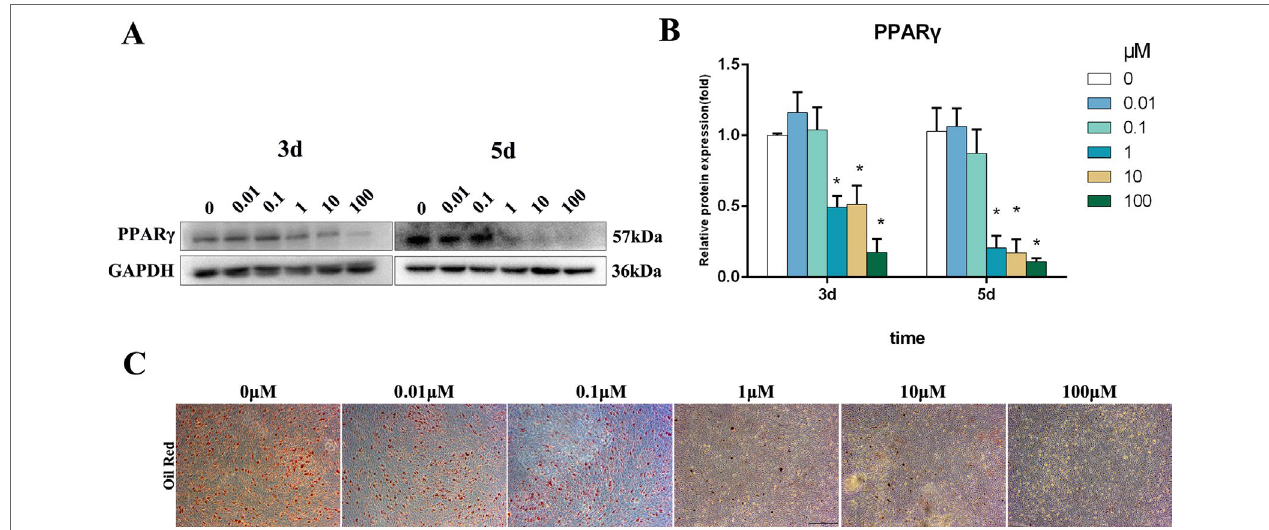
FIGURE 3 | Effects of Bergenin on adipogenesis of bone marrow mesenchymal stem cells (BMSCs). (A and B) The expression of PPAR γ protein was determined by Western blot analysis after adipogenic differentiation at days 3 and 5. Protein expression levels were normalized to glyceraldehyde-3-phosphate dehydrogenase. * P < 0.05 vs. BMSCs treated with osteogenic induction medium alone. (C) Oil Red O staining at days 14 of adipogenic differentiation. Magnification ×40.